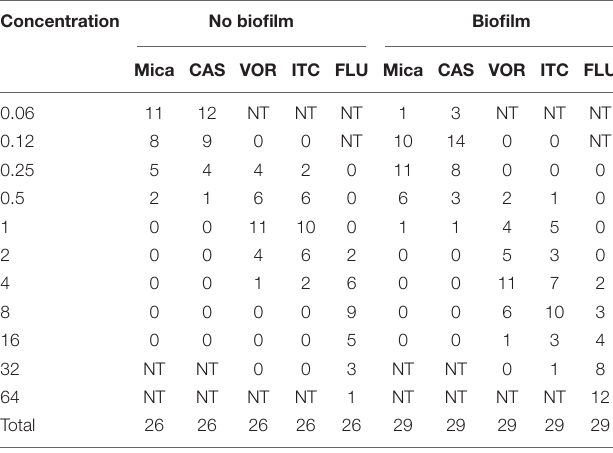
TABLE 2 | The number of strains with MIC50 value of different drugs in the 55 Candida albicans after biofilm formation experiment in vitro . Concentration